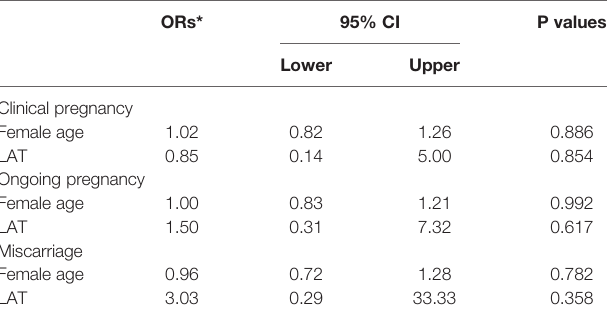
TABLE 5 | Multi-variate analysis with GEE on clinical outcomes after blastocyst transfer. ORs* 95% CI P